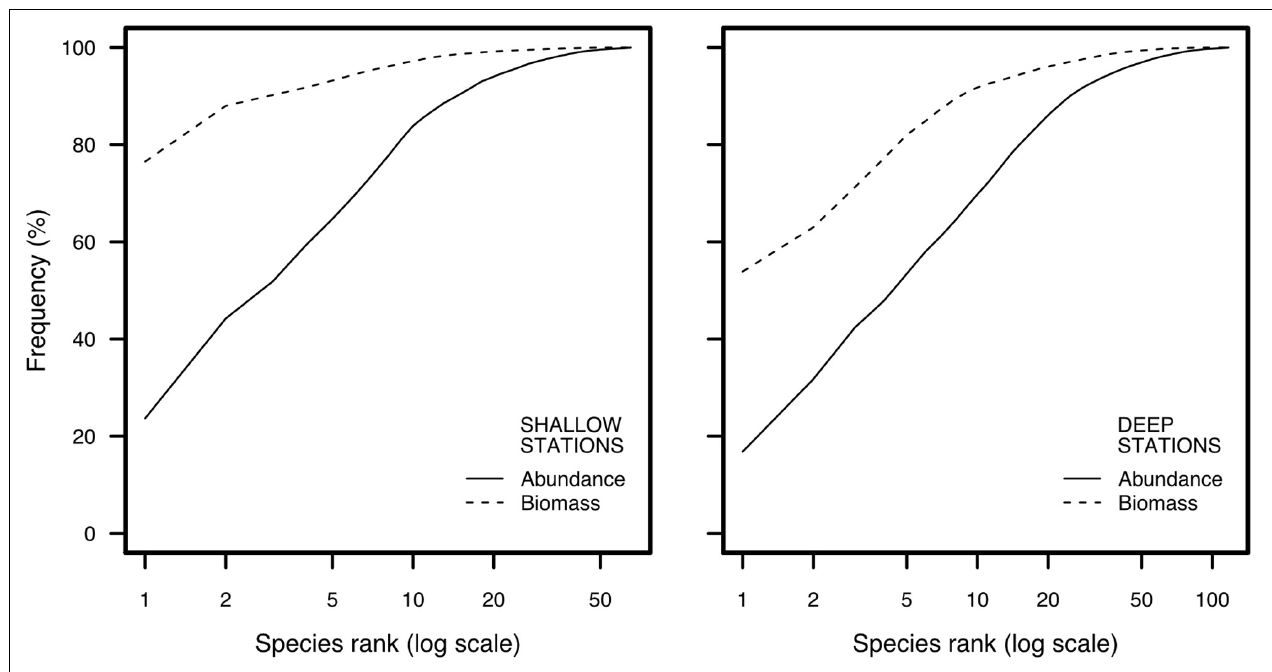
FIGURE 2 | Values of abundance and biomass for ranked species (logarithm scale), for shallow stations and deep